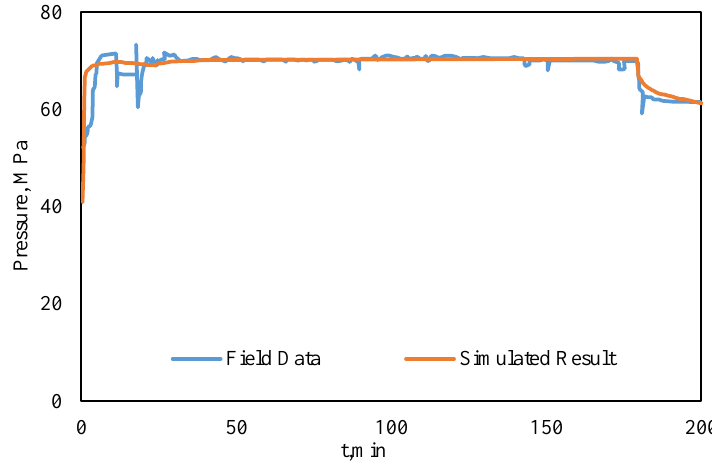
Figure 5—History match of bottomhole pressure for Well A during fracture treatment.